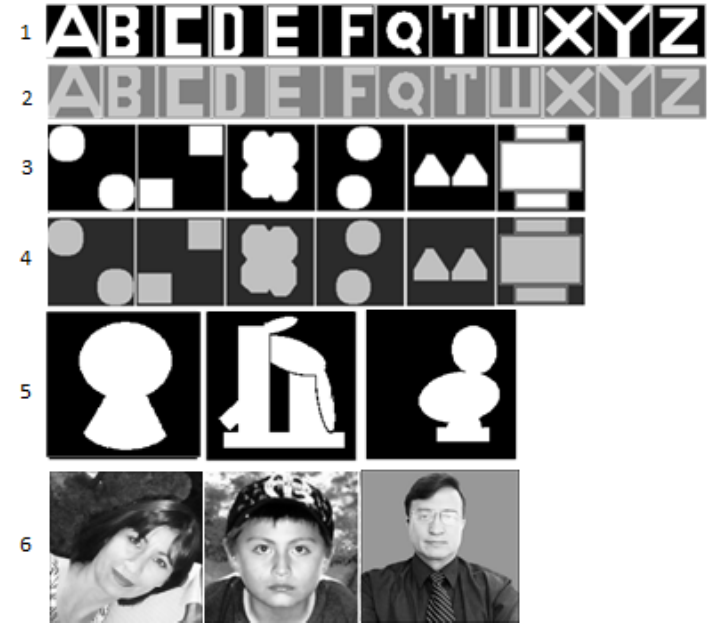
Figure 16. Fundamental sets.